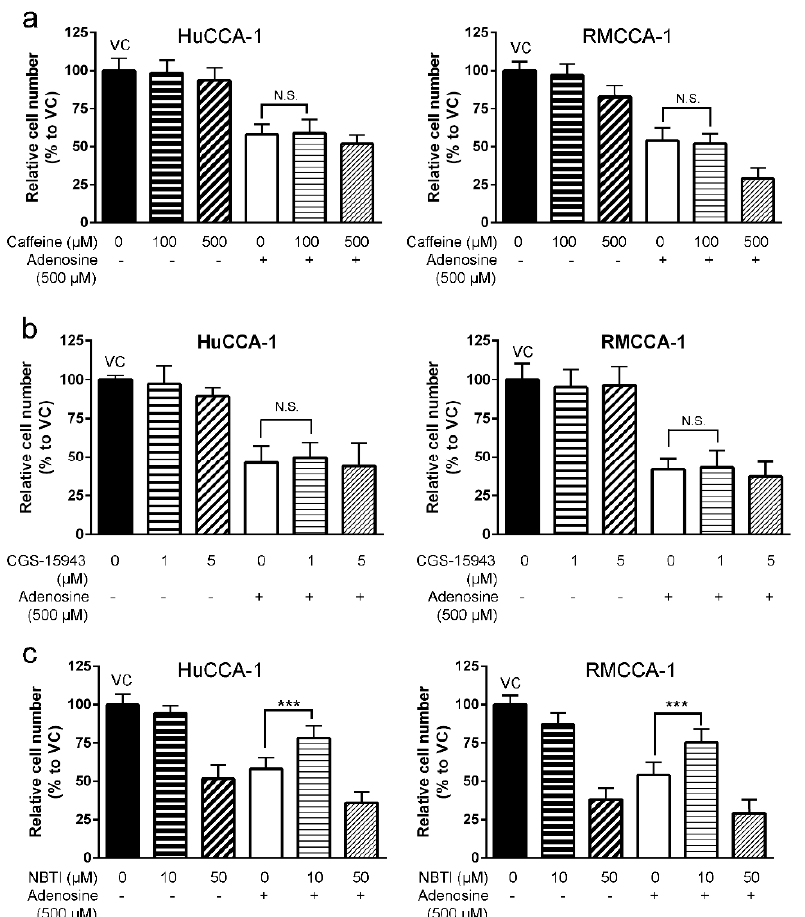
Figure 3. Adenosine inhibited CCA cell growth in a receptor-independent mechanism. ( a ) Caffeine, an antagonist for A1, A2a and A2b receptors, showed no significant effect on adenosine-mediated CCA cell growth suppression in viability MTT assay. ( b ) CGS-15943, a pan antagonist of adenosine receptors, showed no significant effect on adenosine-mediated CCA cell growth suppression in viability MTT assay. ( c ) Inhibitory effect of adenosine on cell growth subsided when 10 µ M (4-nitrobenzyl)-6-thioinosine (NBTI), a broad inhibitor of equilibrative nucleoside transporters (ENTs), was applied 1 h prior to adenosine treatment. VC; vehicle control, N.S.; not significant, *** p < 0.001. All experiments were performed using at least three biological replicates with internal triplicate. Graphs are plotted as mean ±